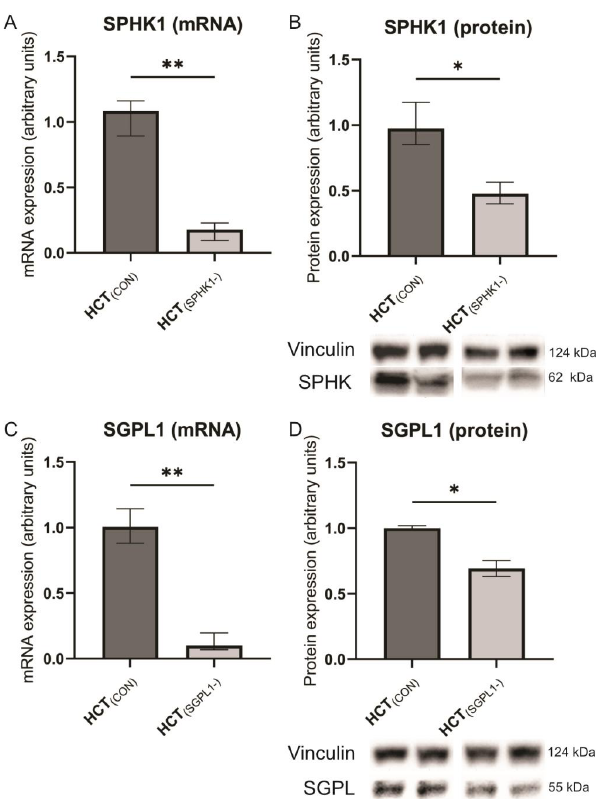
Figure 2. The impact of particular gene silencing on the expression of SPHK1 (panels A and B ) and SGPL1 (panels C and D ) in human colorectal carcinoma HCT-116 cell line. Values are con- trol-normalized medians +/ − interquartile ranges (n = 6 qPCR; n = 4 WB). Bands from two inde- pendent representative WBs are presented below protein expression graphs; * p < 0.05; ** p < 0.01 vs. control (HCT (CON) ).